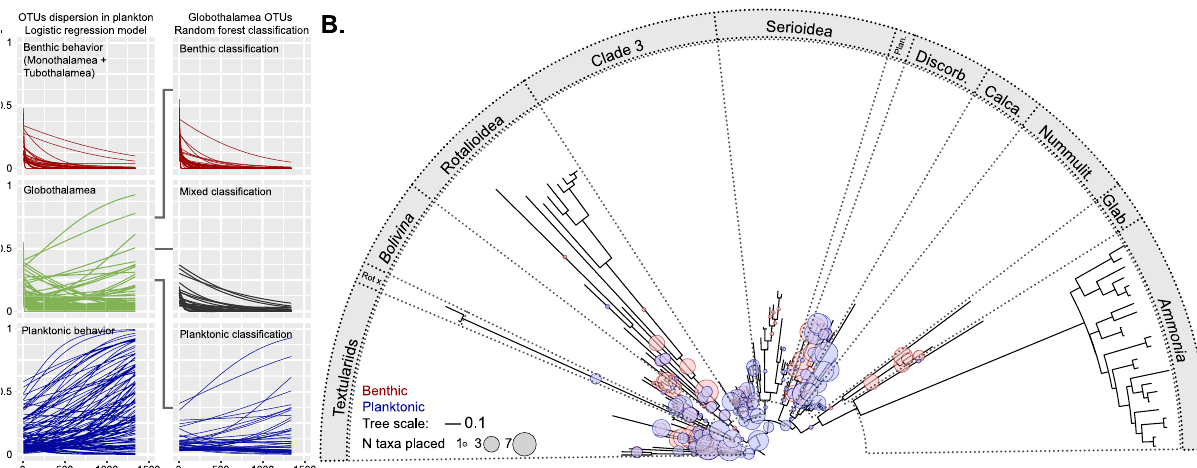
Fig. 3 | Identi fi cation of “ putative planktonic ” Globothalamea. A Random Forest classi fi cation of the GlobothalameaMOTUs as either planktonicor benthic. B Phylogenetic placement of the MOTUs on the Globothalamea tree. The main clades of benthic foraminifera are delimited on the tree. The size of the circles represent the number of potential MOTUs af fi liated with a branch. Note that the